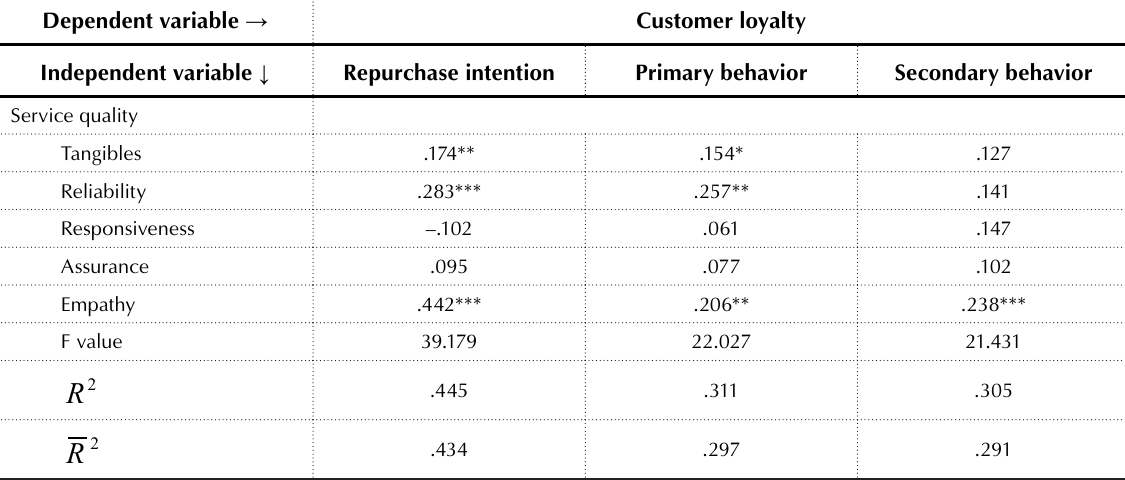
Data source: self-organized in this